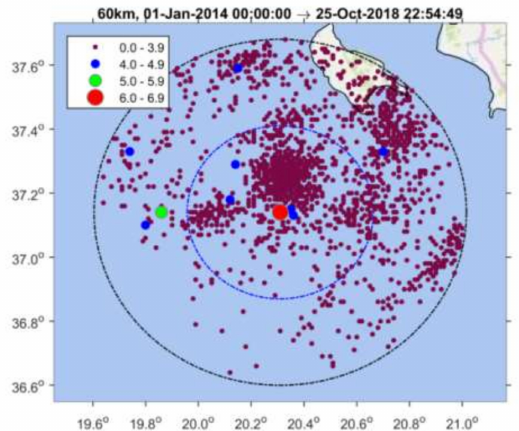
Figure 3. Spatial distribution of earthquakes listed in the National Observatory of Athens (NOA) catalogue and occurring from 1 January 2014 to the 25 October 2018 mainshock occurrence (red circle) within radii of R = 60 km and R = 30 km from the mainshock epicenter. Color panel shows scaling of earthquake magnitude